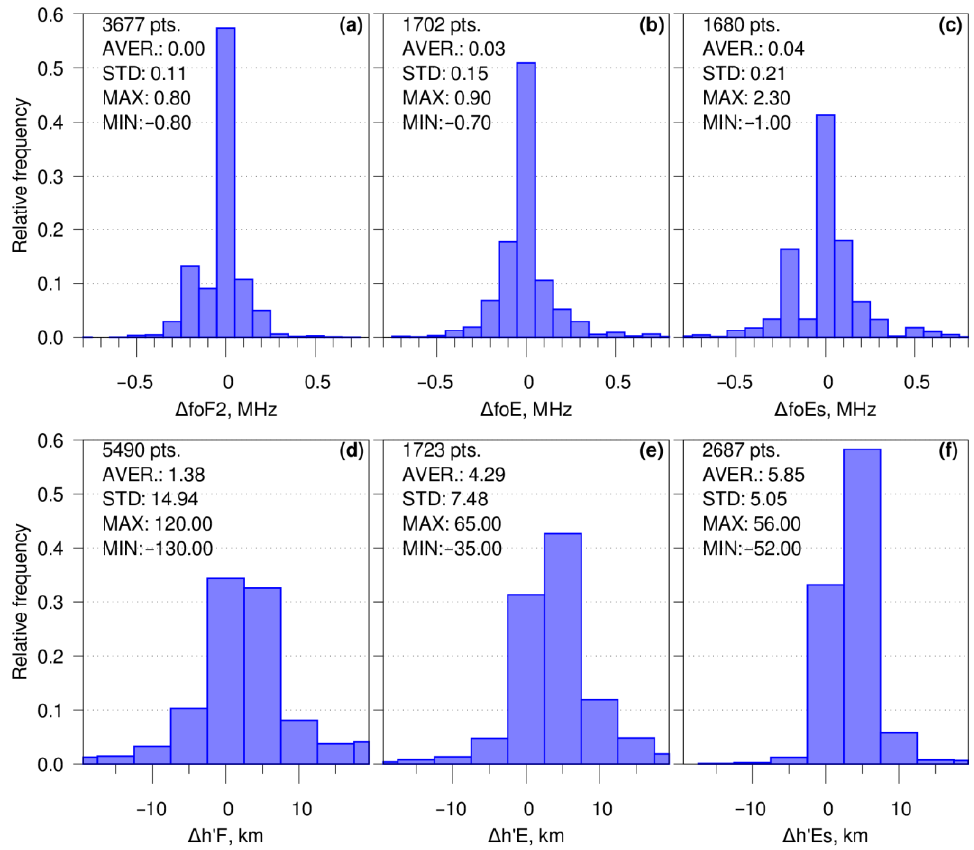
Figure 8. Distribution of the differences in critical frequencies ( a ) ΔfoF2, ( b ) ΔfoE, ( c ) ΔfoEs and virtual heights ( d ) Δh’F, ( e ) Δh’E, ( f ) Δh’Es for the 2021. Additional information can be found in Supplementary Materials.